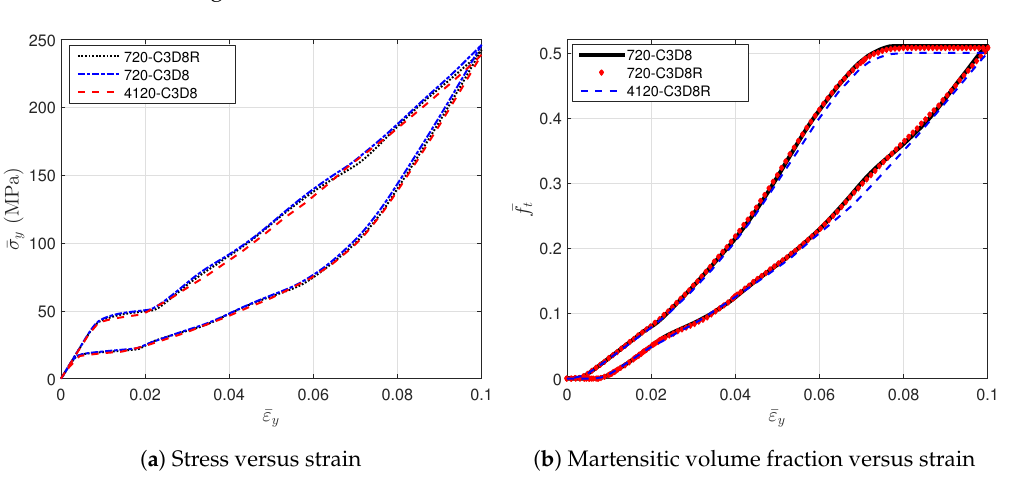
Figure 2. The evolution of the averaged stress and the averaged martensitic volume fraction simulated by RVEs with different